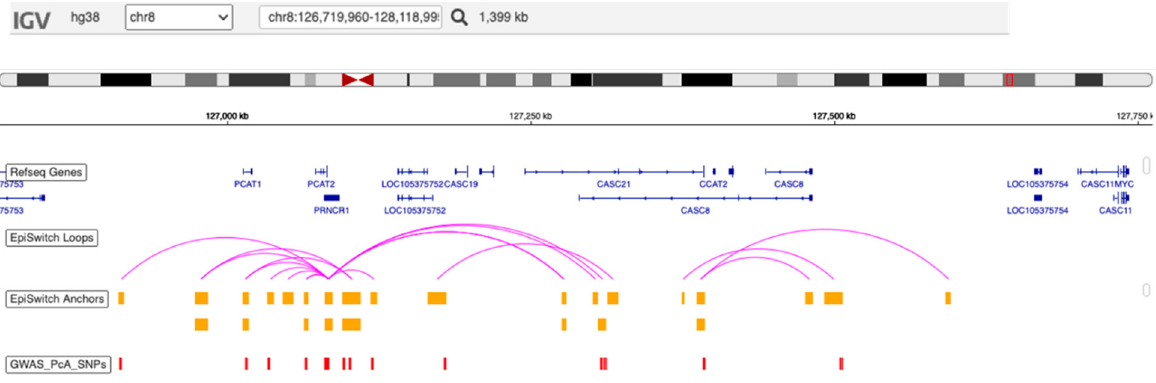
Figure 4. Schematic depiction of the overlap between the anchors of Episwitch loops and known PCa related SNPs on chromosome 8 from GWAS. The image shows the overlap of the anchoring sites of EpiSwitch 3D genomic markers, identified in early whole genome screening stage of EpiSwitch biomarker development [21,22], with positions of PCa SNPs from GWAS Catalogue on 8q24 chromosome region.